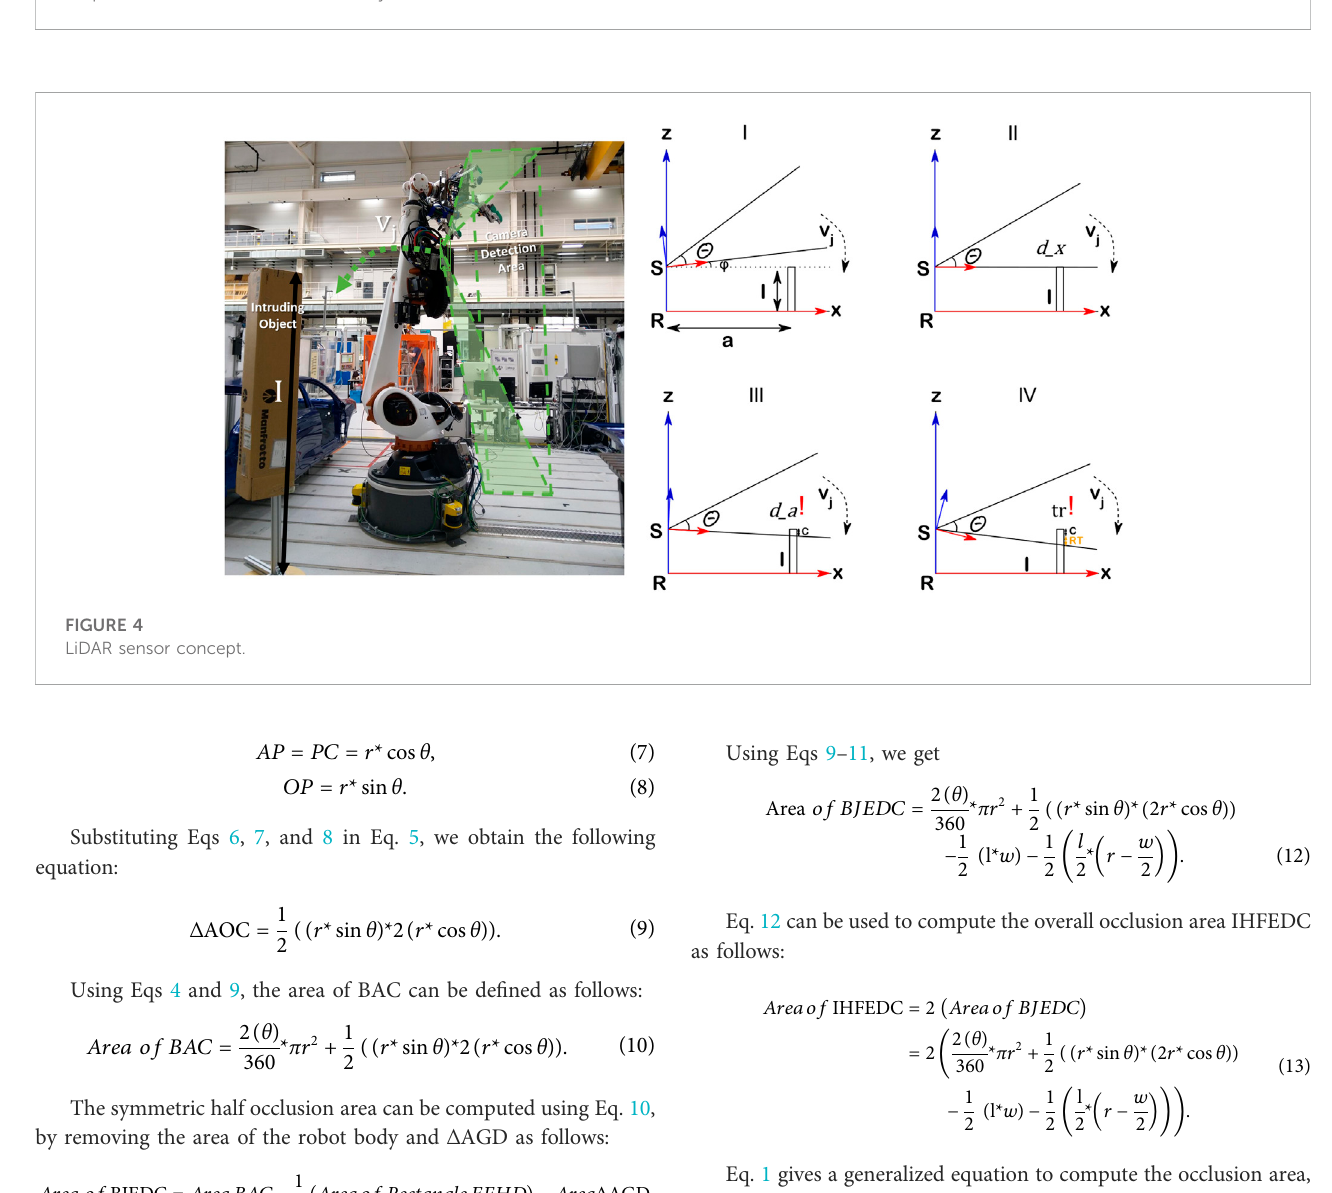
FIGURE 3 Proposed fl exible and ef fi cient sensor system.